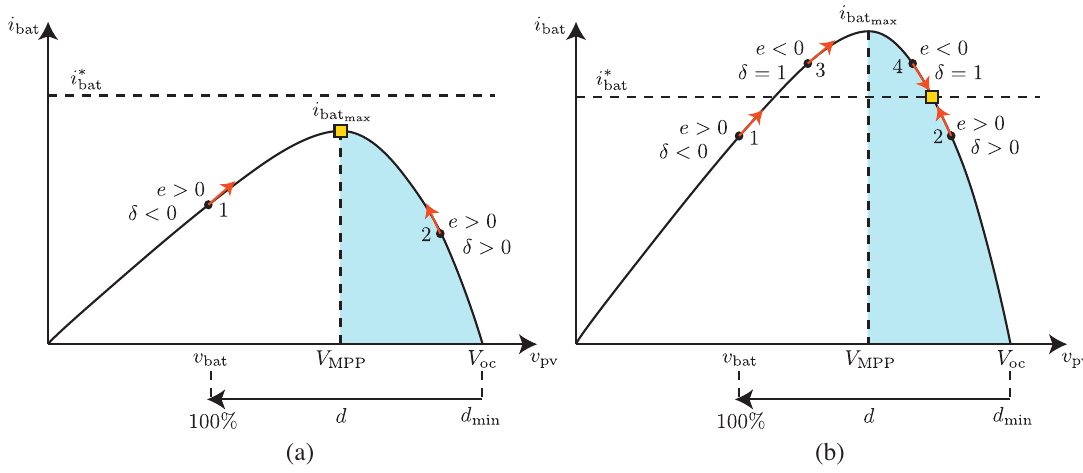
Figure 7. Control performance against the two possible scenarios: ( a ) requested power is higher than available PV power; ( b ) requested power is lower than available PV power.